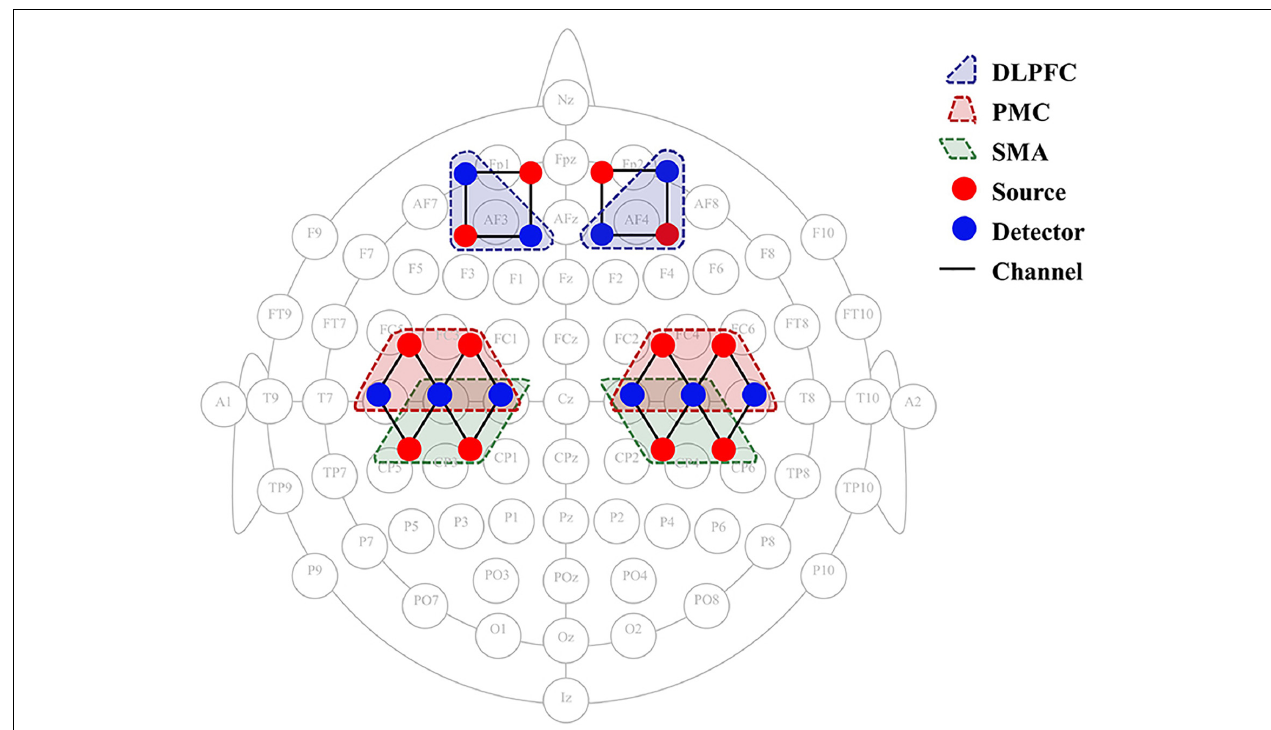
FIGURE 3 | fNIRS 24-channel placement. SMA, supplementary motor cortex; PMC, premotor cortex; DLPFC, dorsolateral prefrontal cortex; fNIRS, functional near-infrared spectroscopy.